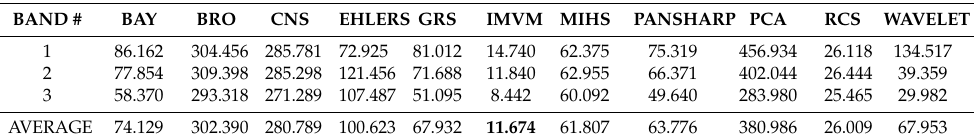
Table 6. Spectral consistency: root square mean error (RMSE).